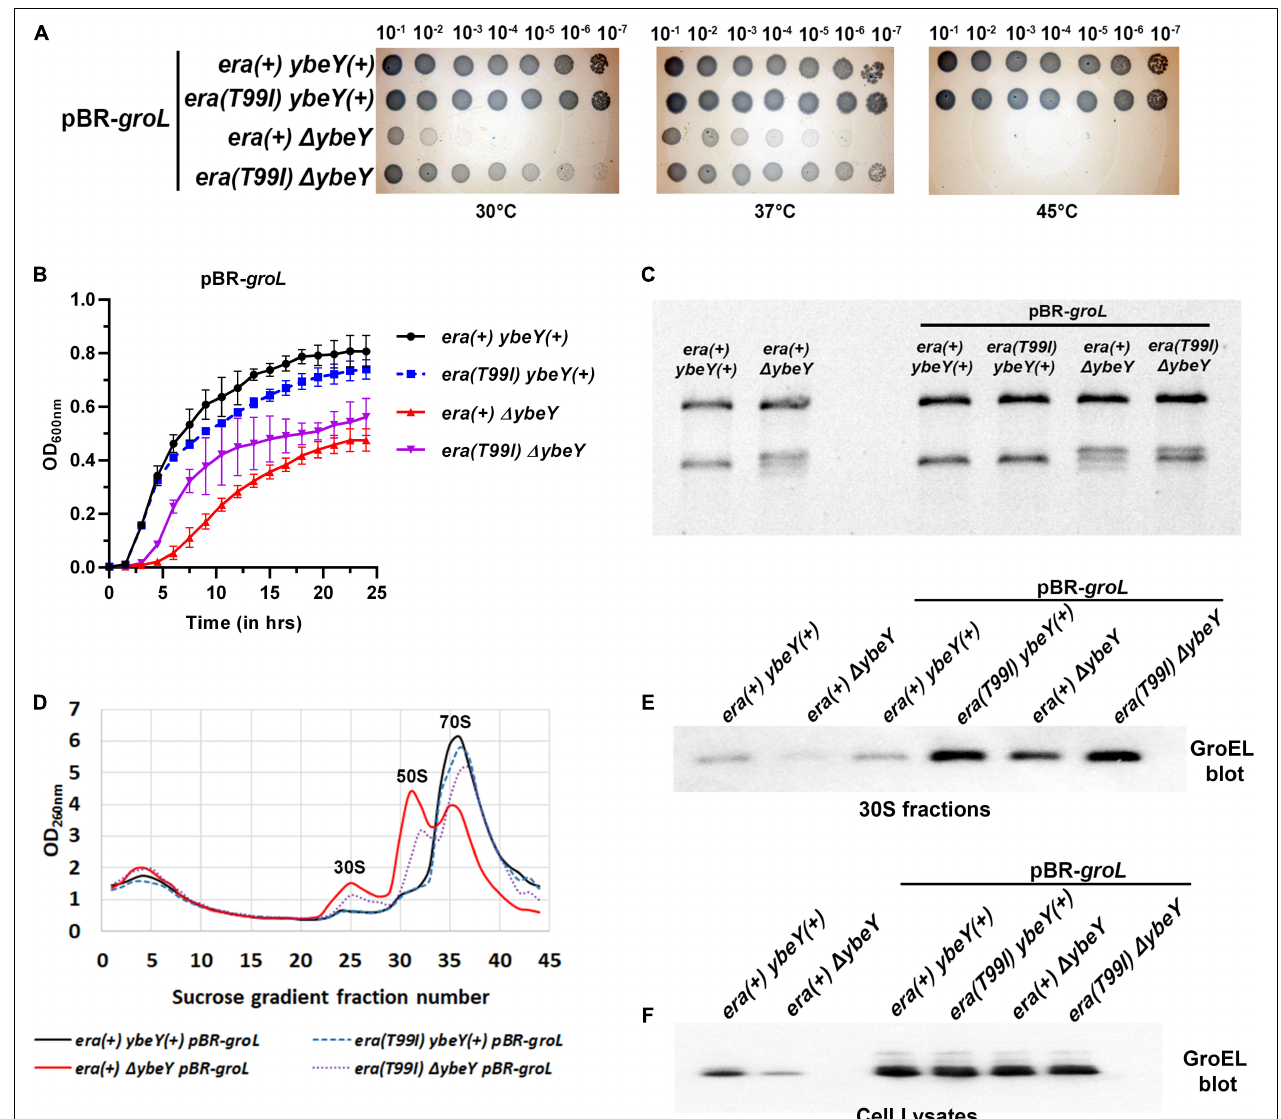
FIGURE 7 | (A) Tenfold serial dilutions of the overnight cultures of the indicated strains were spotted onto LB agar plates and incubated at the indicated temperatures for 16 h. Representative sections of the imaged plates are shown. (B) Growth curves of strains era( +) ybeY( +) pBR- groL (black, continuous line, circles), era(T99I) ybeY( +) pBR- groL (blue, broken line, squares), era( +) (cid:49) ybeY pBR- groL (red, continuous line, triangles), and era(T99I) (cid:49) ybeY pBR- groL (purple, broken line, inverted triangles) determined in liquid LB media at 37 ◦ C by measuring OD at 600 nm in a plate reader for 24 h. The average ± SD of three determinations is shown. (C) Total RNA extracted from the indicated strains was separated using Synergel-agarose gel electrophoresis. Representative gel images of at least three independent determinations is shown. (D) Total cell lysate of the strains era( +) ybeY( +) pBR- groL (black, continuous line), era(T99I) ybeY( +) pBR- groL (blue, broken line), era( +) (cid:49) ybeY pBR- groL (red, continuous line), and era(T99I) (cid:49) ybeY pBR- groL (purple, broken line) separated by sucrose gradients and the amount of RNA was determined by measuring absorbance at 260 nm. Western blot analysis of GroEL protein levels in the 30S fractions (E) and in the cell lysates (F) from the indicated strains.